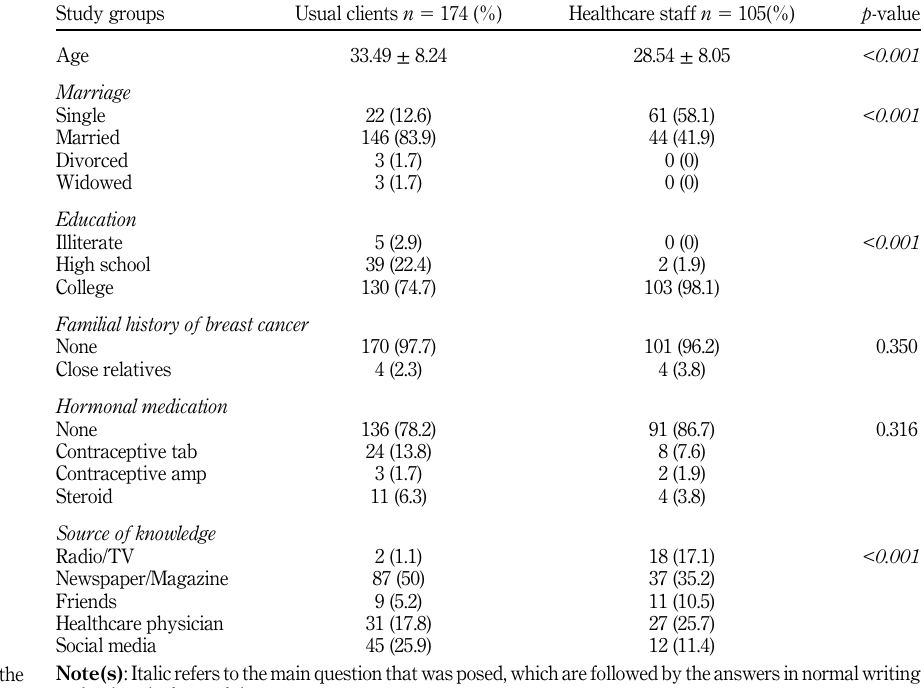
characteristics of the study groups